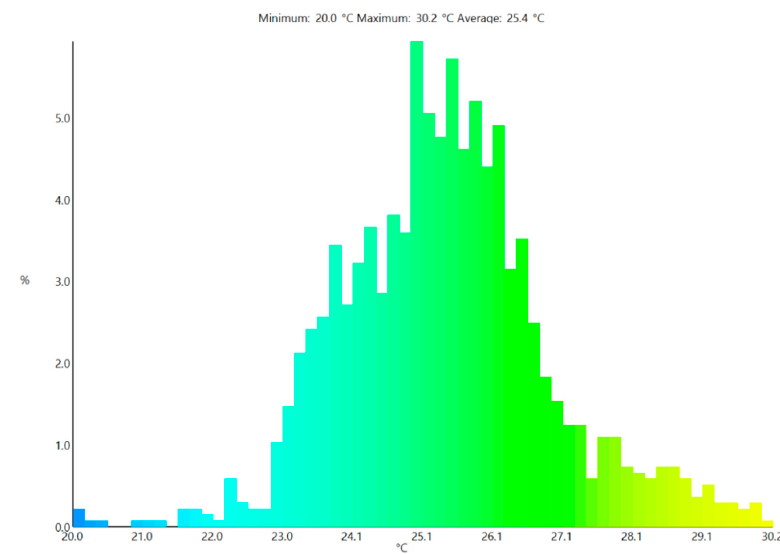
Figure 9. Time dependence of temperature of the two PV panels.